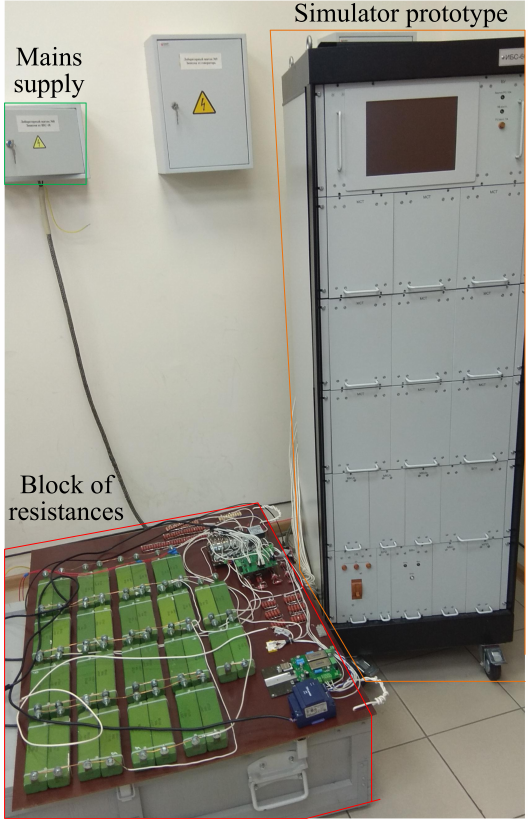
Figure 13. Experimental test